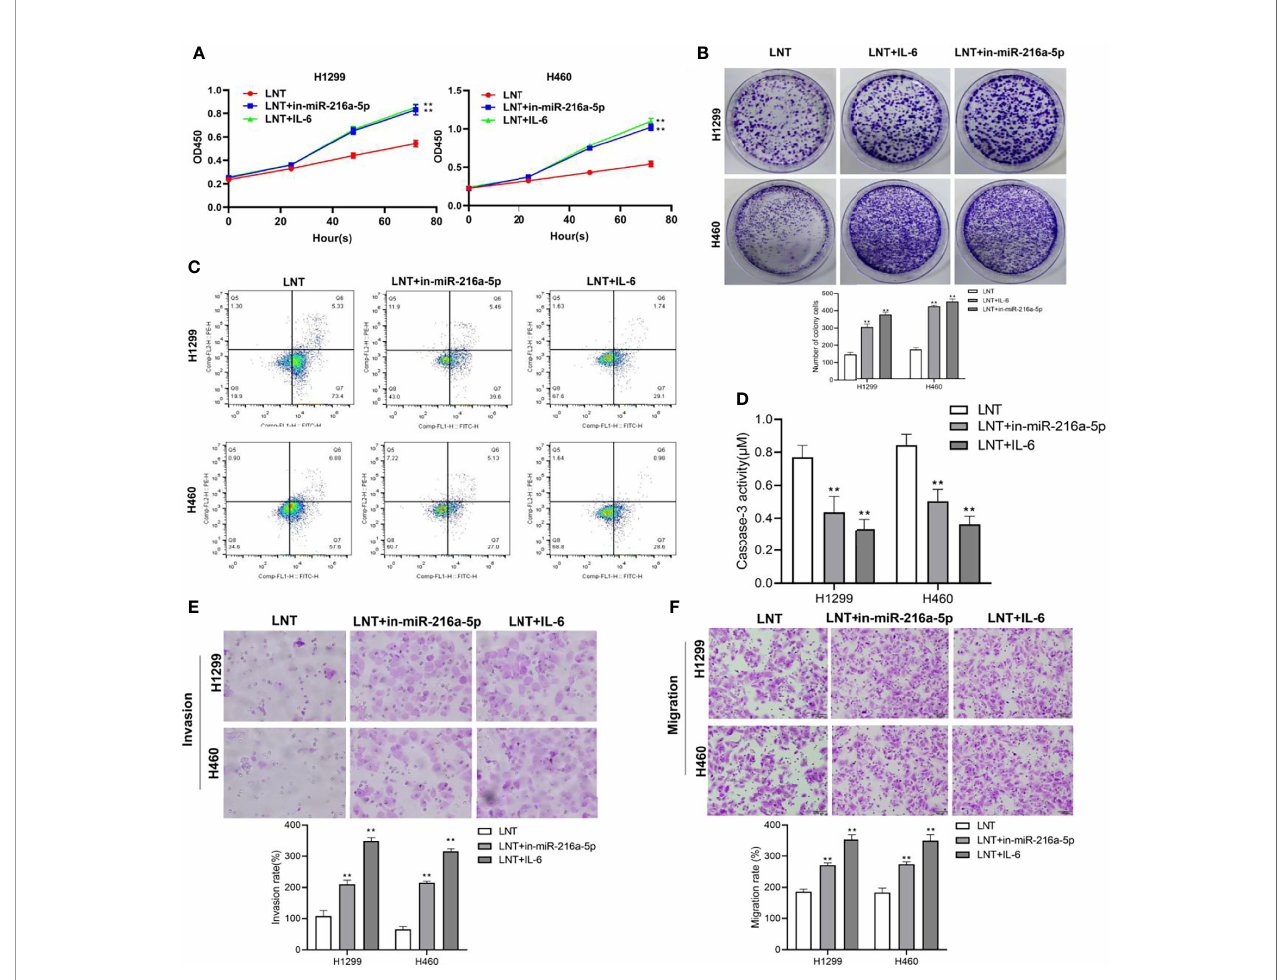
FIGURE 4 | Interference with miR-216a-5p or the addition of IL-6 on LNT anti-cancer effects. (A) CCK8 detects H1299 and H460 cell proliferation in each group; (B) Cell colony experiment detects H1299 and H460 cell viability in each group; (C) H1299 and H460 cell apoptosis in each group detected by fl ow cytometry; (D) Detection of H1299 and H460 cell Caspase3 activity in each group; (E) Transwell detects H1299 and H460 cell invasion ability in each group; (F) Transwell detects of H1299 and H460 cell migration ability in each group. **P < 0.01 vs . LNT